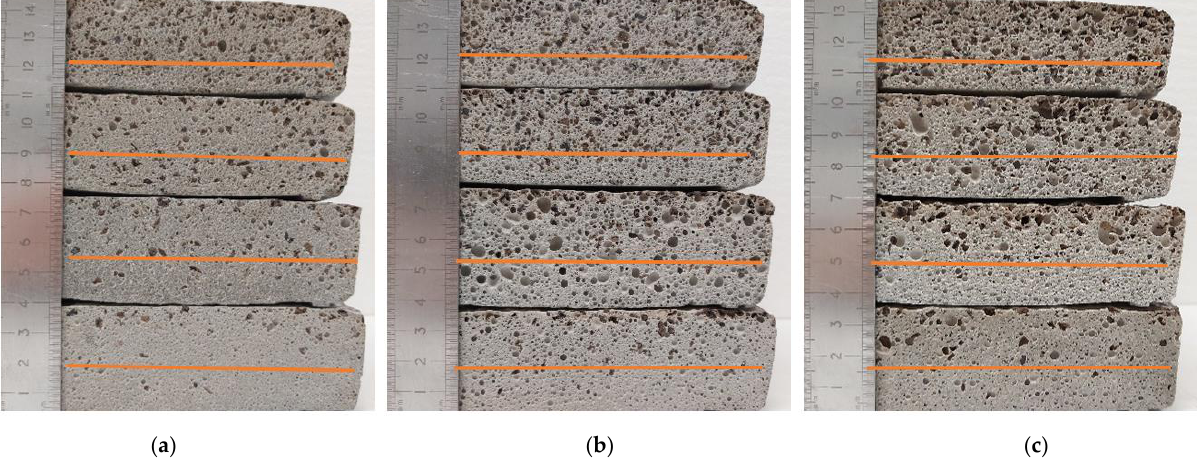
Figure 7. Cross-section of AA-LFM versus cork particles content using 0.009 w.% Al; ( i ) P1F1Cn*, ( ii ) P2F1Cn* and ( iii ) P3F1Cn*. Where (*n: 10 to 40% cork).